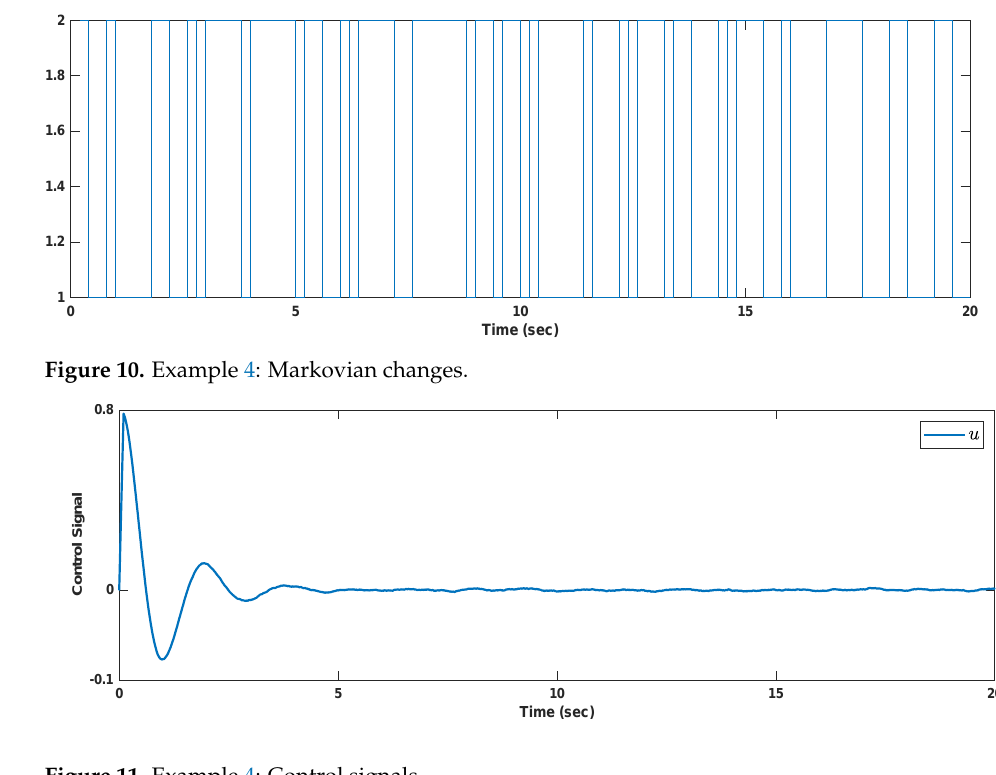
Figure 11. Example 4: Control